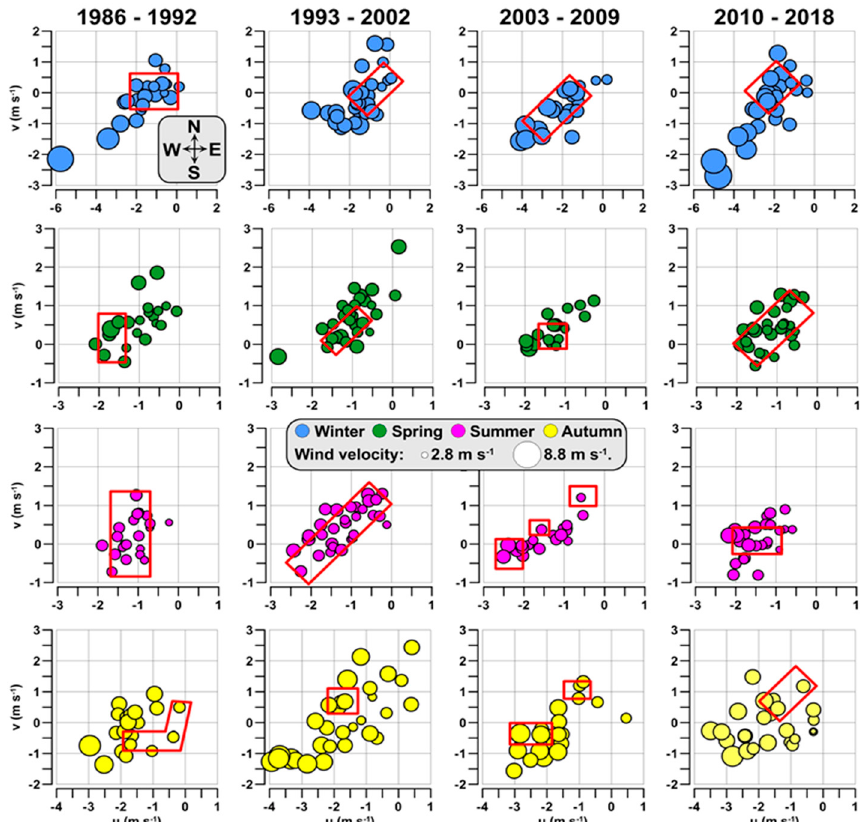
Figure 7. Monthly mean velocity of the wind at sea surface in the GoT (bubble size; m s − 1 ) in comparison to eastward wind component (u; m s − 1 ) and northward wind component (v; m s − 1 ), in 1986–2018. Red squares indicate the months with a higher phytoplankton abundance (Figure 3A). In the first plot, cardinal points indicate that winds blowing from NE have u < 0 and v < 0, winds blowing from SE have u < 0 and v > 0.